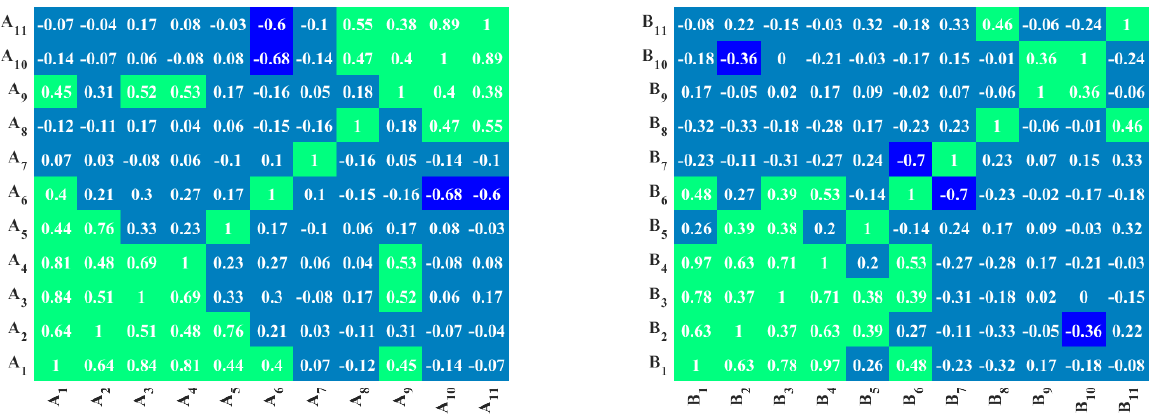
Figure 3. P -value of independent indicators of PE and IC